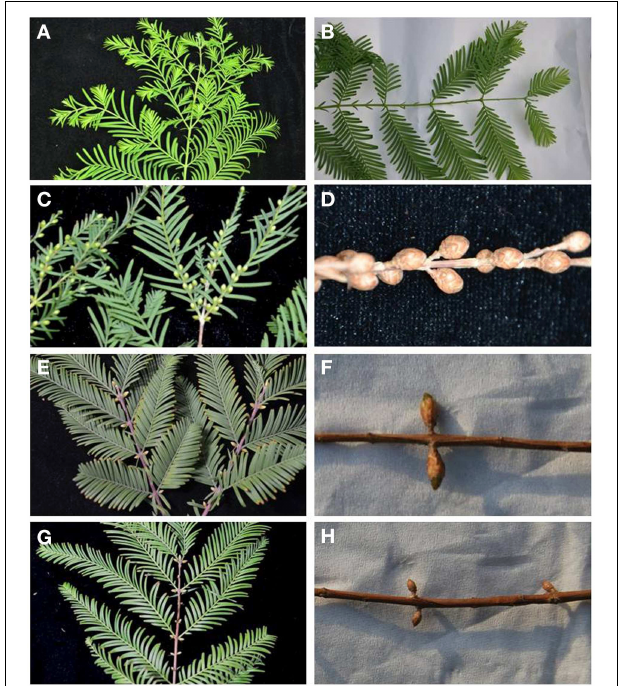
FIGURE 1 | Male buds and female cones on hormone-treated shoots. (A) Shoots before hormone treatment collected on May 24th, 2013. (B) Shoots before hormone treatment collected on June 11th, 2013. (C) Male buds on treated shoots collected on Sept 15th, 2013. (D) Male cones on treated shoots collected on Feb 5th, 2014. (E) Female buds on treated shoots collected on Oct16th, 2013. (F) Female buds on treated shoots collected on Mar 5th, 2014. ( G) Untreated shoots (control) with vegetative buds collected on Oct 16th, 2013. (H) Untreated shoot (control) with vegetative buds collected on Mar 5th,